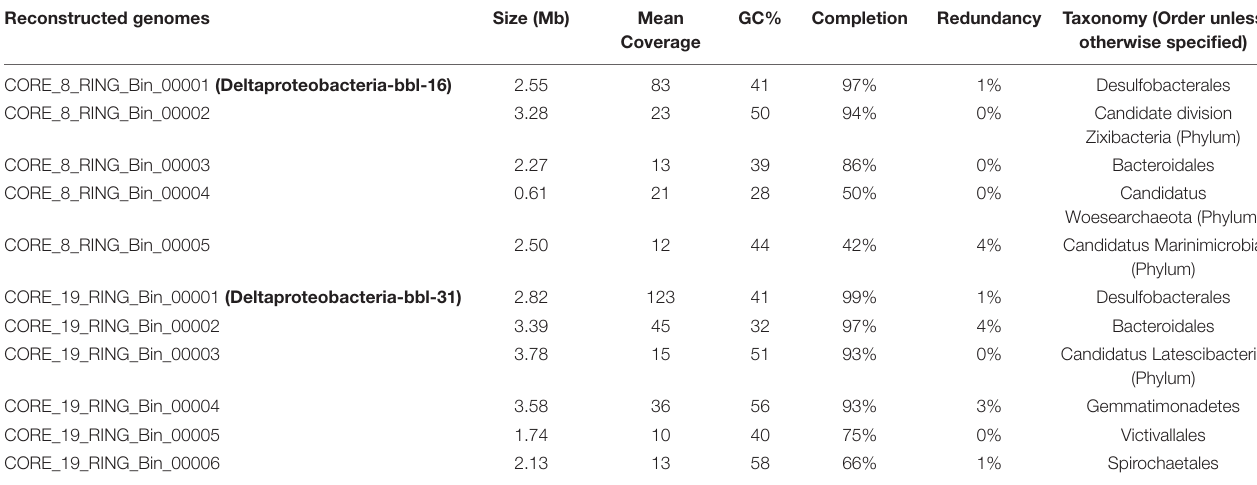
TABLE 1 | Reconstructed genome statistics including genome size, mean coverage, GC content, estimated percent completion and redundancy, and taxonomic classification. Reconstructed genomes Size